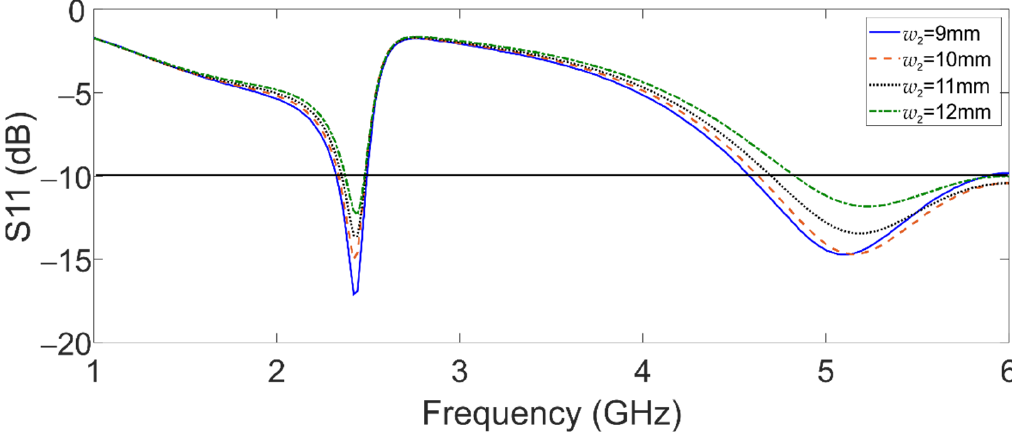
Figure 3. Simulated reflection coefficient of the dual ‐ band graphene antenna for w 2 variations.